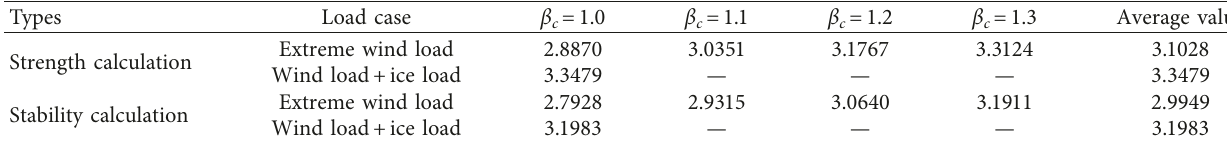
Table 10: Reference value β